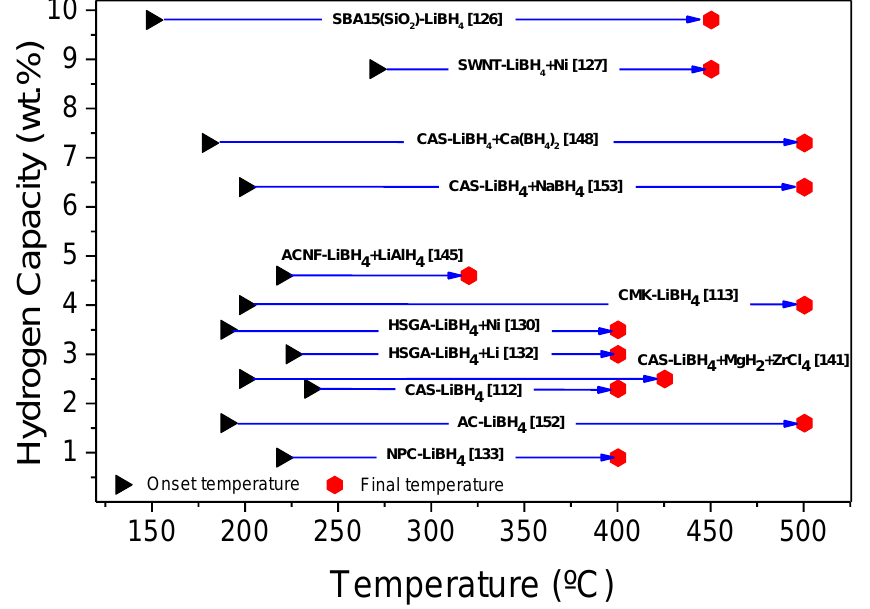
Figure 9. Experimental hydrogen capacity against the temperature range for the first dehydrogenation for several nanoconfined metal / metal compound added LiBH 4 and LiBH 4 + binary / complex hydride systems.